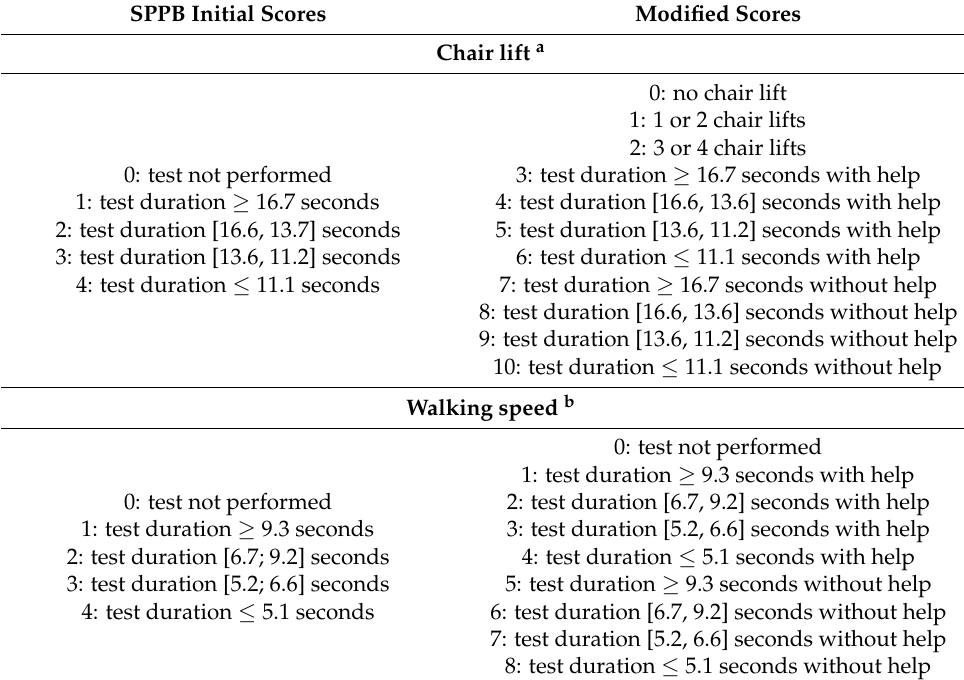
Table 1. The adaptation of chair lift and walking speed scores